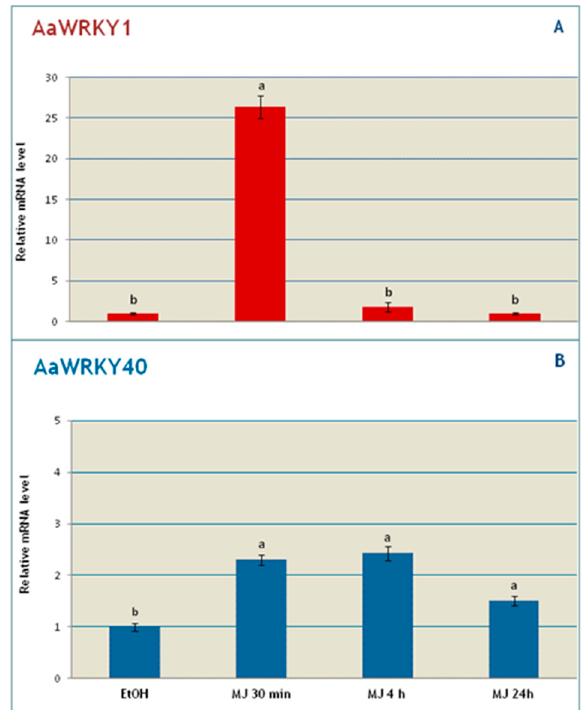
Figure 4. Estimation of the relative mRNA levels of AaWRKY1 ( A ) and AaWRKY40 ( B ) in A. annua suspension cultures treated with 22 μ M methyl jasmonate (MJ). Ethanol (EtOH) was used to dissolve methyl jasmonate and added to control samples. Data were submitted to one-way ANOVA with Tukey's post-hoc test, different letters denote significant differences between control and treatment ( p < 0.05).